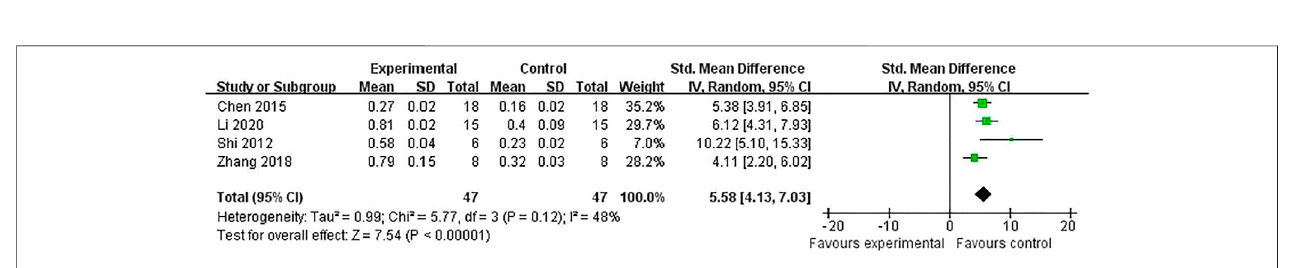
FIGURE 5 | The pooled estimate of RRC for decreasing TUNEL-positive cells.